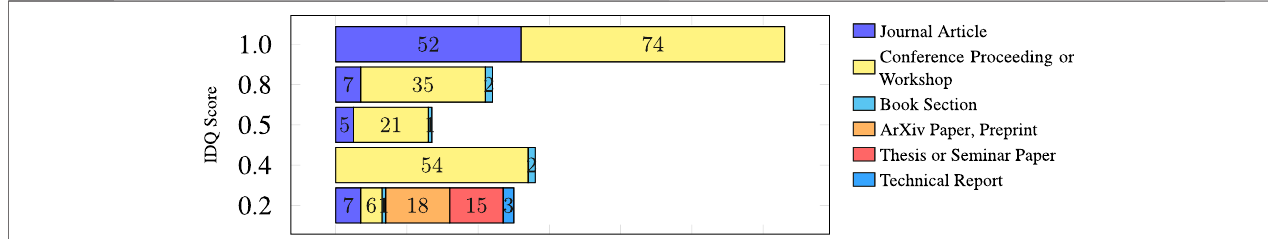
FIGURE 2 | Number of publications per IDQ score, by publication venue.